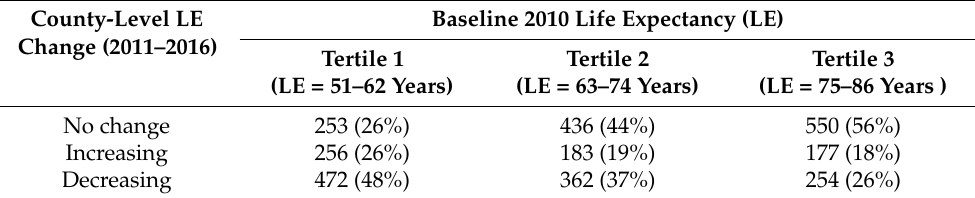
Figure 1. County-level life expectancy change in the United States, 2011–2016. Table 1. Comparison of county-level life expectancy (LE) change from 2011 to 2016 and baseline 2010 life expectancy.